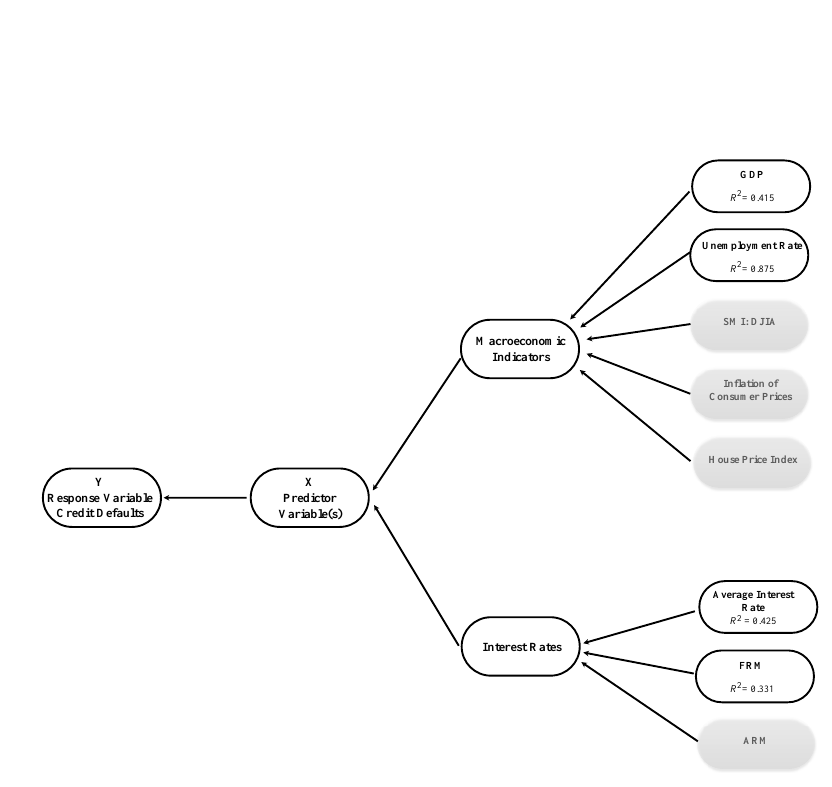
Fig. 4. The model of results for the USA market (developed by the author).